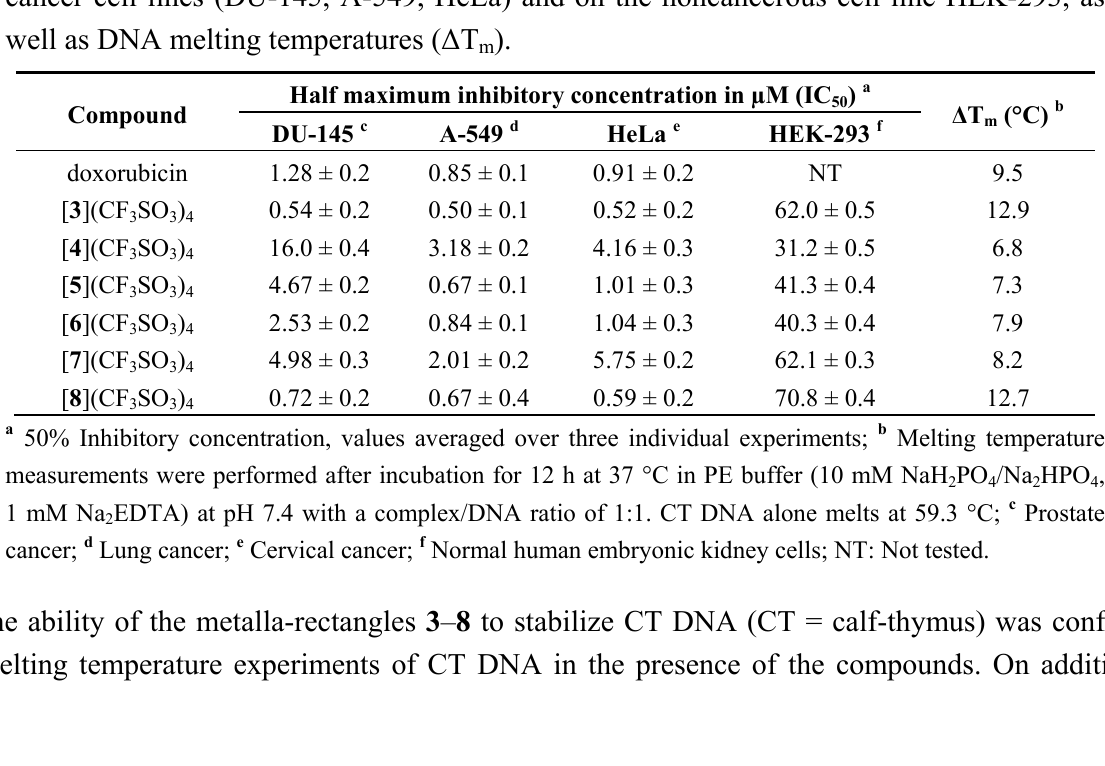
values ( μ M) of compounds [ 3 ](CF 50